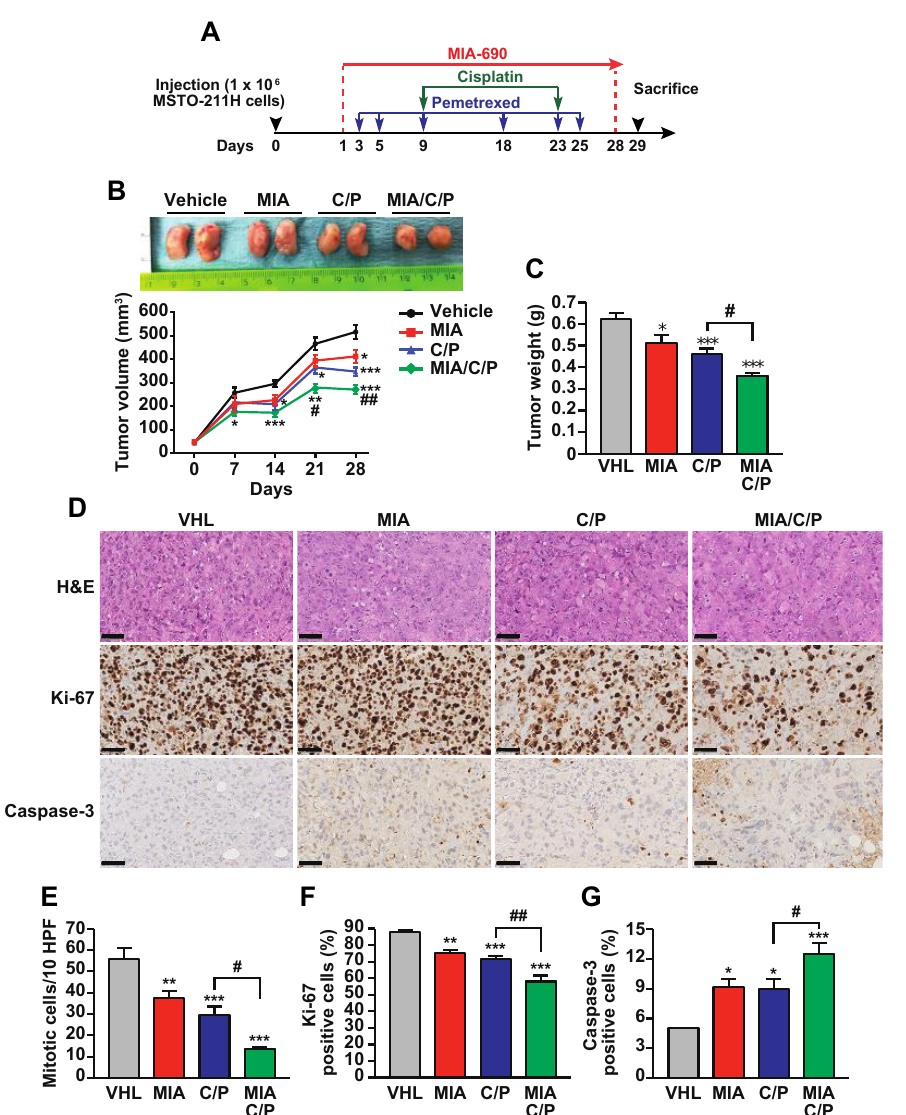
Figure 2. Inhibitory effects of MIA-690 in PM in vivo in combination with cisplatin and pemetrexed. ( A ) Experimental protocol: at day 1, when MSTO-211H tumor volume was over 40 mm 3 , mice were